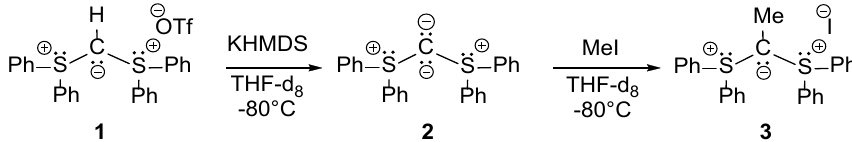
Scheme 1. Synthesis of S,S - bis - ylide 2 and alkylation reaction with